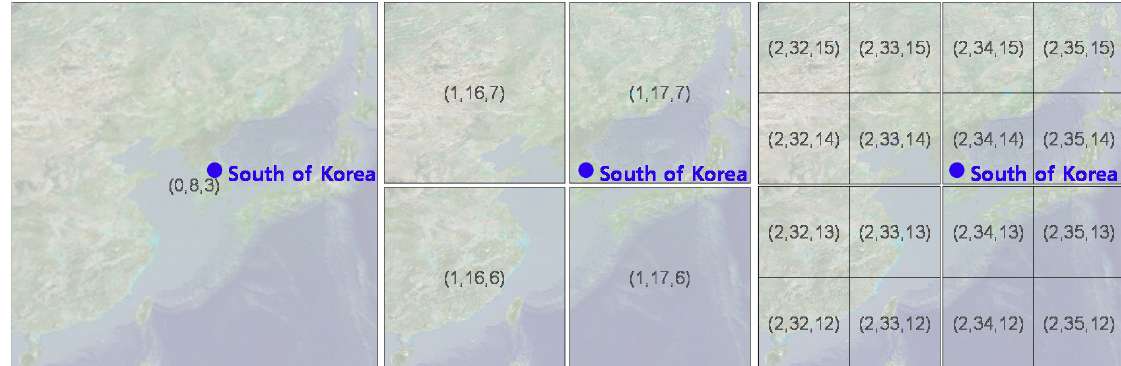
Figure 13. Country name in the level 0 tile with rendering property C2AL given to lower level tiles (level, IDX, IDY).